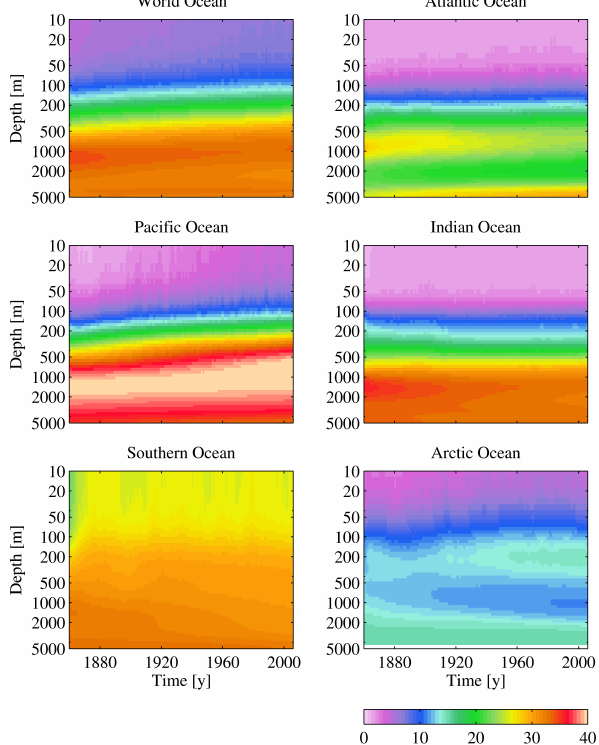
Fig. 31. Simulatedvertical profiles ofdissolved inorganic nitrogen concentration averaged for theWorld Ocean ( top Fig. 37. Simulated vertical profiles of dissolved inorganic nitrogen left )and5majorregions. ConcentrationsinmmolNm − 3 . Notethatdepthisshownonalogarithmicscale. concentration averaged for the World Ocean (top left) and 5 major regions. Concentrations in mmolNm − 3 . Note that depth is shown on a logarithmic